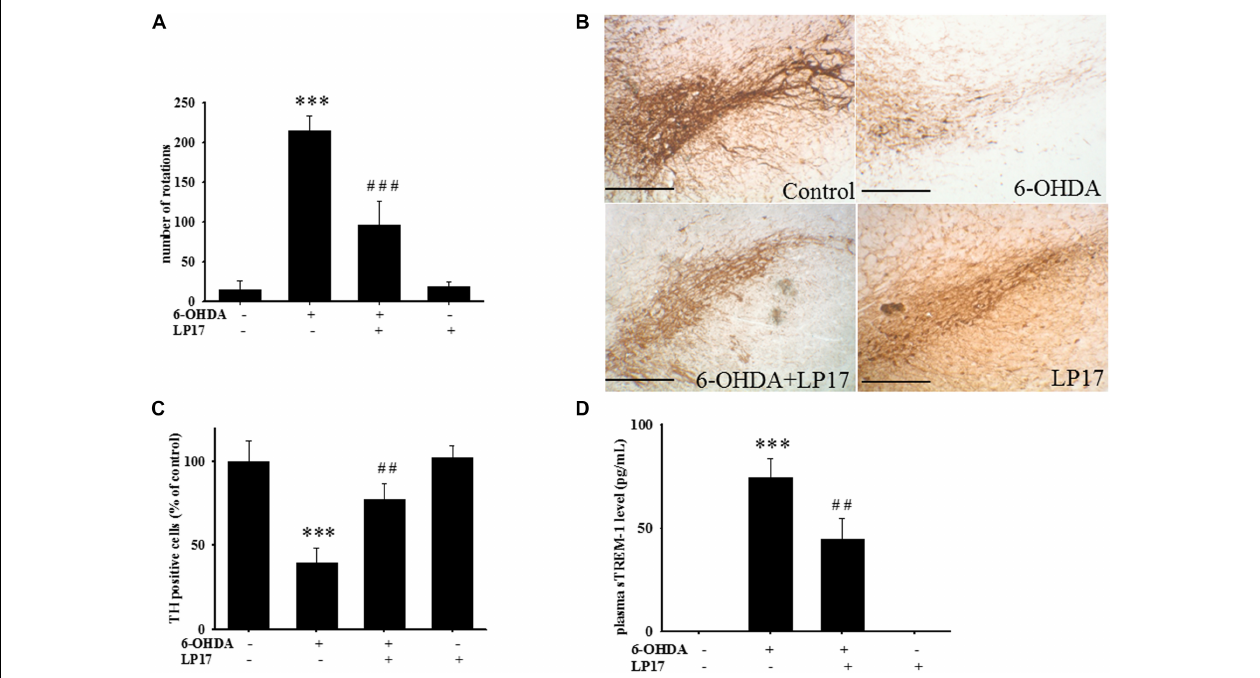
FIGURE 8 | Treatment of LP17 rescued 6-OHDA-induced upregulation of the number of amphetamine-induced rotation behavior, downregulation of TH expression, and upregulation of plasma sTREM-1 in rat model ( n = 5/group). (A) Analyses of the number of rotations at 14 days after development of lesions in the 6-OHDA group and the 6-OHDA plus LP17 group after the rats were treated with either the control peptide or 40 µ g/kg of LP17 (1 µ g/ µ l for a 10- µ l solution) plus 5 µ g 6-OHDA. It showed that LP17 significantly reversed the 6-OHDA-induced increase in the number of rotation behaviors. (B,C) Whole-mount immunohistochemistry and quantitative result of TH-positive cells for TH expression at 14 days after development of lesions in the control, 6-OHDA, 6-OHDA plus LP17, and LP17 alone groups. LP17 significantly reversed the 6-OHDA-induced downregulation of TH (scale bar = 100 µ m). (D) Based on the plasma level of sTREM-1 at 14 days after development of lesions in the control, 6-OHDA, 6-OHDA plus LP17, and LP17 alone groups, LP17 significantly attenuated the 6-OHDA-induced upregulation of sTREM-1 in plasma. The bars represent the mean ± SEM. The data were analyzed using two-way ANOVA. ∗∗ P < 0.05; ∗∗∗ P < 0.001 versus the control group;